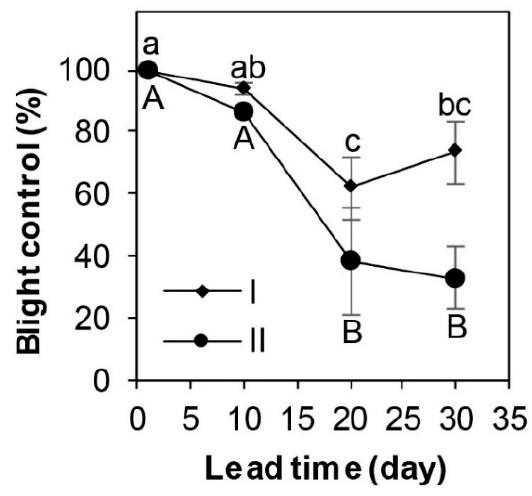
Figure 4. Blight control by SSG at 10 8 cfu/mL decreased with increasing application lead time prior to inoculation with Calonectria pseudonaviculata at 1 to 2 × 10 4 conidia/mL. Each data point is a mean blight control of three replicate Justin Brouwers boxwood plants and is presented with a standard error bar. Means marked with the same small case letter did not differ in the first run and those with the same uppercase letter did not differ in the repeated run according to the LSD test at p = 0.05.